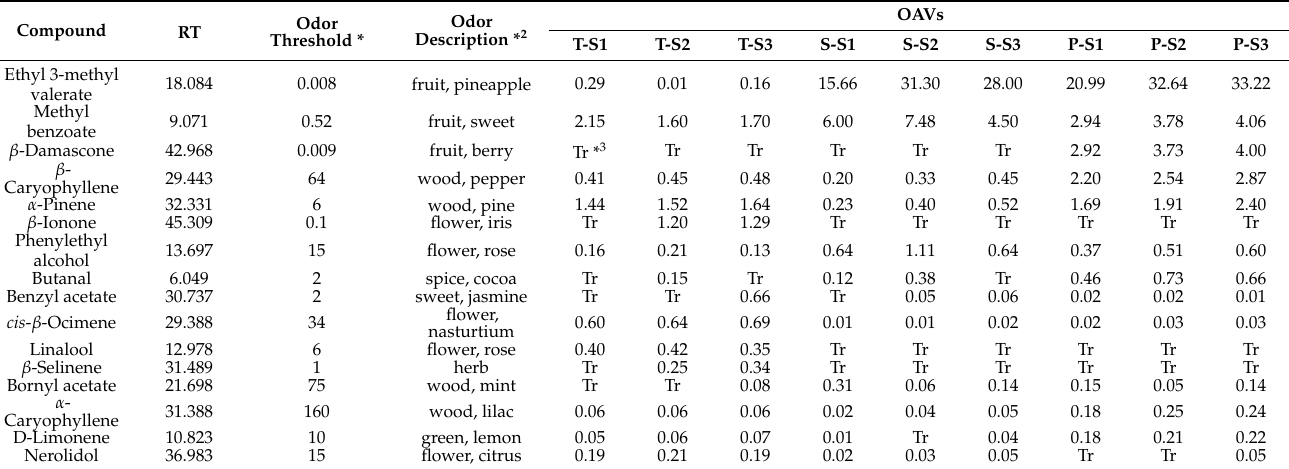
Table 2. Volatile components with odor activity values more than 0.1 (OAVs > 0.1) in M.